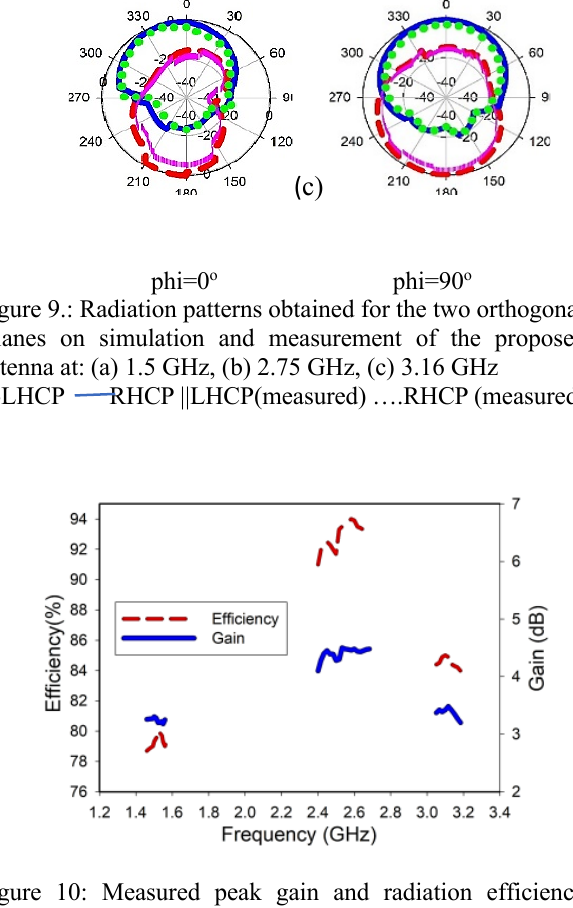
Figure 10: Measured peak gain and radiation efficiency values versus frequency for the proposed